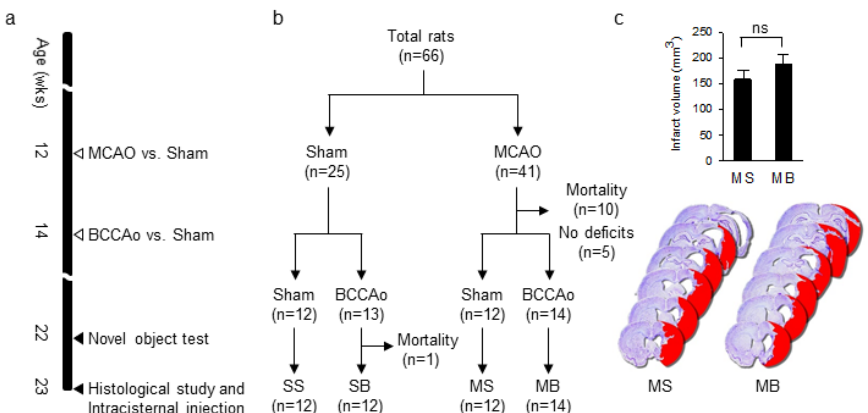
Figure 1. ( a ) The time line of the experiment. ( b ) Allocation of rats into groups. ( c ) Quantification of the infarct volume and representative images of cresyl violet staining in MS and MB rats. n = 6 in both groups; MCAO, middle cerebral artery occlusion; BCCAo, bilateral common carotid artery occlusion; SS, sham + sham; SB, sham + BCCAo; MS, MCAO + sham; MB, MCAO + BCCAo; ns, not significant.